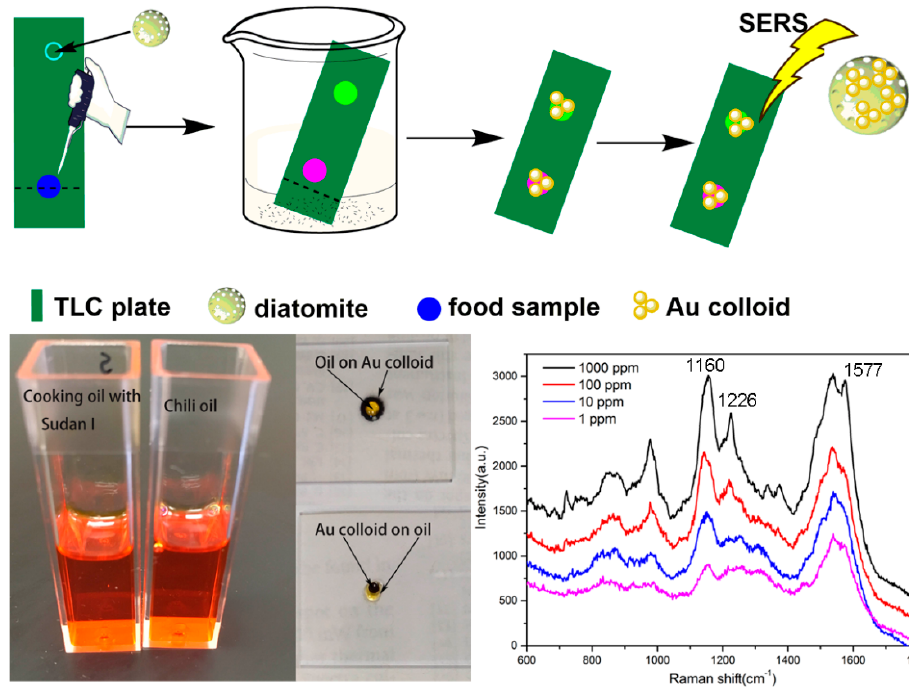
Figure 3. Schematic representation of the TLC-SERS method by diatomite plate and the application for detecting Sudan dye in chili oil. Reprinted with permission from ref. [67]; Copyright 2017 Else- vier.